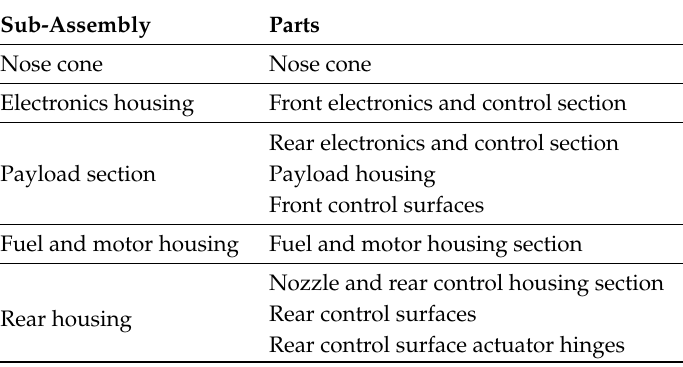
Table 4. AIM-120 airframe parts and